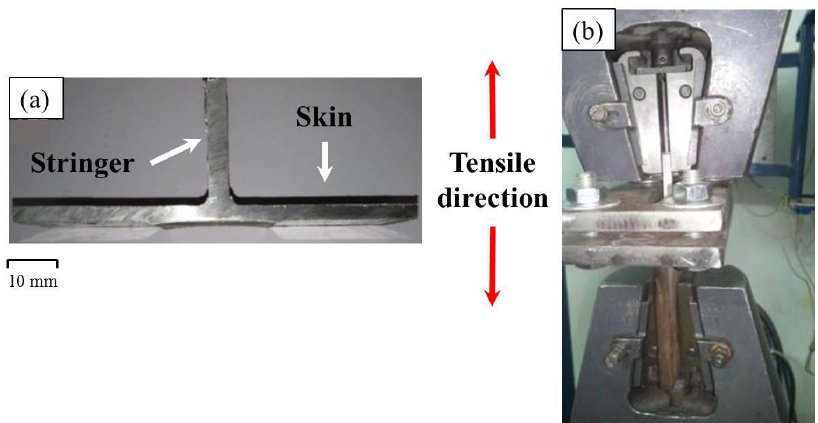
Figure 3. Photographs of tensile testing along stringer direction ( a ) T-butt joint tensile test specimen and ( b ) tensile test clamping system.